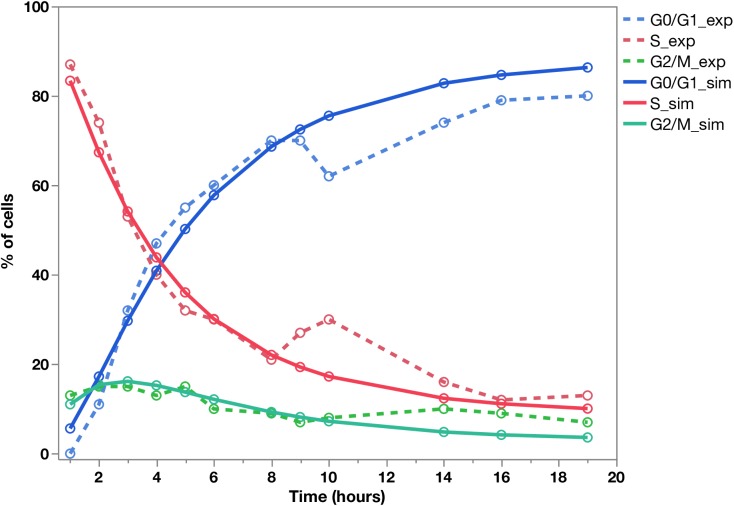
Validation of the mathematical model and parameter values with pulse/chase experimental data from [15].Young B6 mice received a single BrdU pulse, and within the BrdU-labelled cells the percentages of cells in GO/G1, S or G2/M is recorded over a nineteen hour chase period. The points and dashed lines represent Baron experimental data. Simulation of the same pulse chase conditions using our mathematical model, with the mean parameter values (S1 Table) obtained from our 2-month-old B6 mice (n = 4). The points and continuous lines represent the results of our simulation.